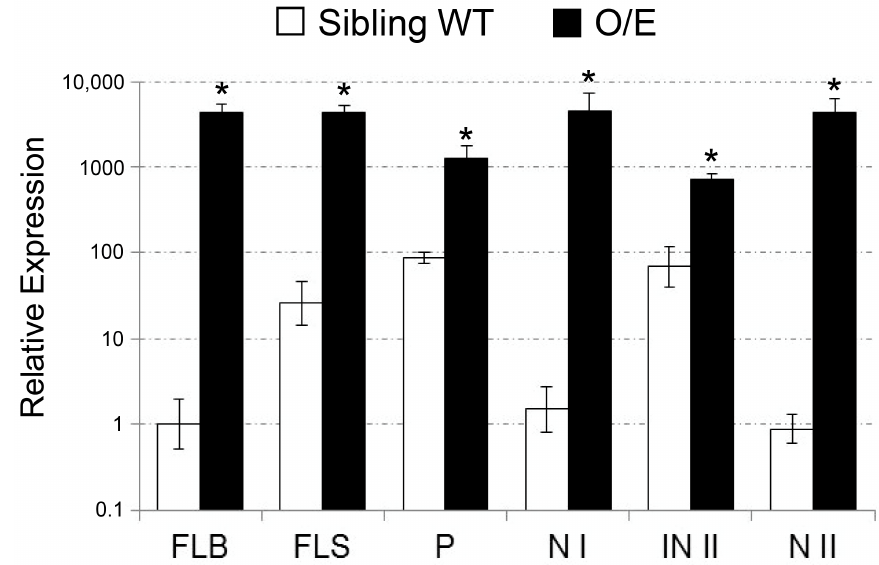
Figure 6. Results of qPCR on the expression of OsHKT1 ; 4 in tissues of the flag leaf and the stem of O/E and sibling WT plants, which were in the reproductive growth stage. Soil-grown plants were treated with salt stress by imposing a gradual 25 mM increase in the NaCl from 25 to 100 mM for more than a month. The transcript level of OsHKT1 ; 4 and an internal control OsSMT3 was analyzed using the following tissues: FLB, the flag leaf blade; FLS, the flag leaf sheath; P, peduncle; N I, node I; IN II, internode II; and, N II, node II. Relative expression of OsHKT1 ; 4 is shown with a logarithmic scale setting its expression in the FLB of WT to 1 ( n = 6, ± SD). An asterisk indicates significant differences between O/E and WT plants (Student’s t -test; * p < 0.001).